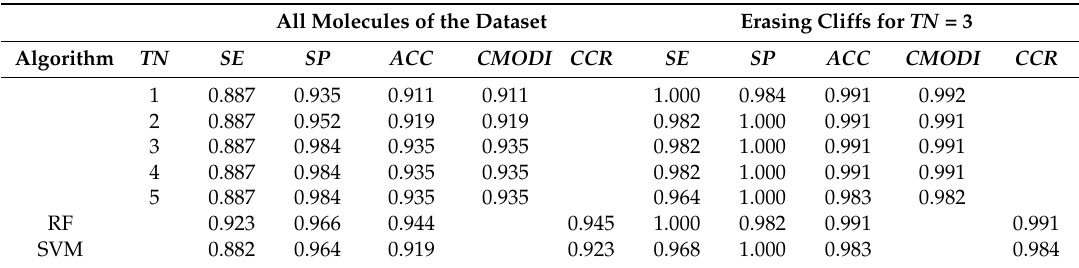
Table 1. Results of the predictions using CMODI for different values of TN and the algorithms for the whole datasets and the dataset erasing the activity cliffs detected for TN =